Question: What does this figure show? Answer in one sentence.
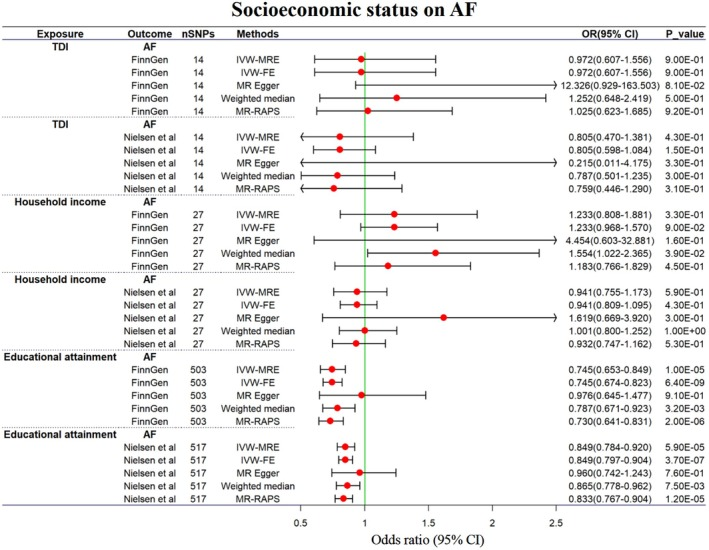
Answer: Forest plots showing the MR estimates of the associations between genetically proxied socioeconomic indicators and AF in FinnGen and the study by Nielsen et al. ORs are expressed per one‐SD increase in each genetically proxied exposure. Higher TDI values indicate greater socioeconomic deprivation, whereas higher household income and EA values indicate higher income and greater educational attainment, respectively.